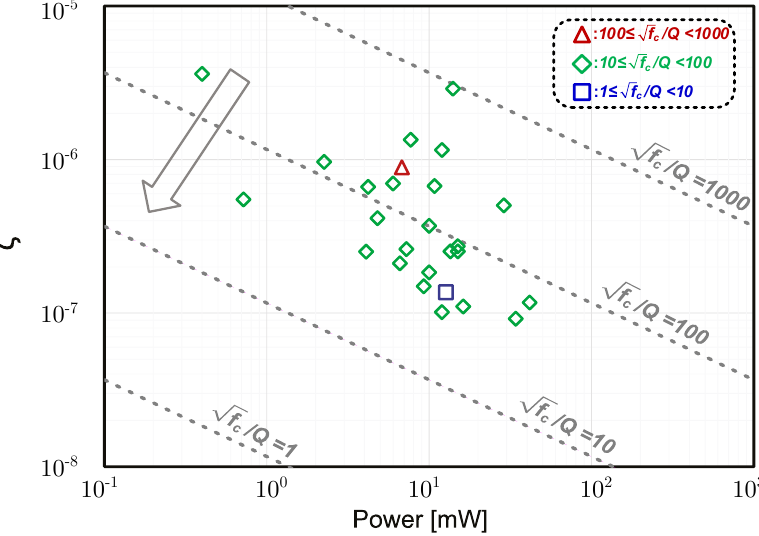
(cid:112) f c / Q . For reference,